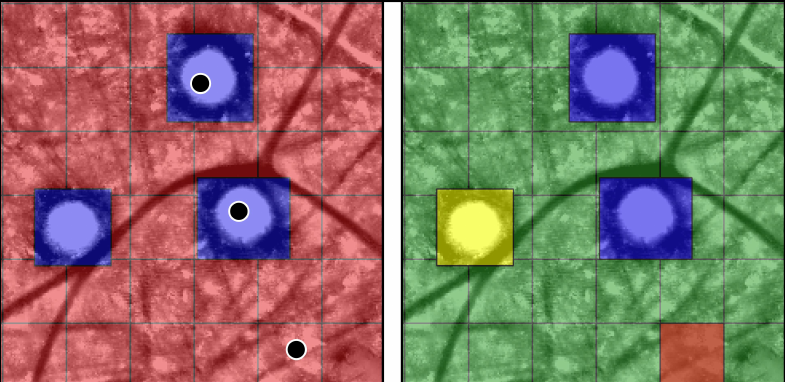
Figure 3. The semi-automatic GIS-based measure [6] for the archaeological evaluation of discrete objects: ( Left ) the detections (black) on the spatial layer with positive grid cells in blue ( (cid:110) ) and negative grid cells in red ( (cid:110) ); ( Right ) results of the processing with detected barrows (TP) in blue ( (cid:110) ), missed barrows (FN) in yellow ( (cid:110) ), wrong detections (FP) in red ( (cid:110) ) and remaining empty grid cells (TN) in green ( (cid:110) ).